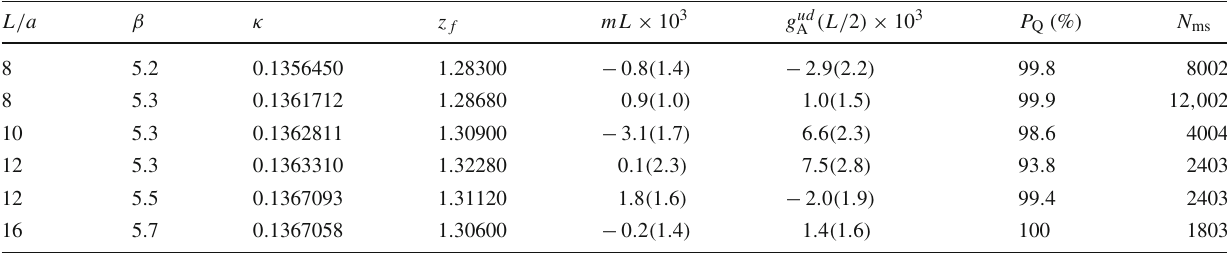
Table 8 Parameters of the N f = 2 ensembles and corresponding results for mL and g ud given by N ms ; these are spaced by 10 MDUs. In the table we also give the percentage P Q of gauge fields with Q = 0